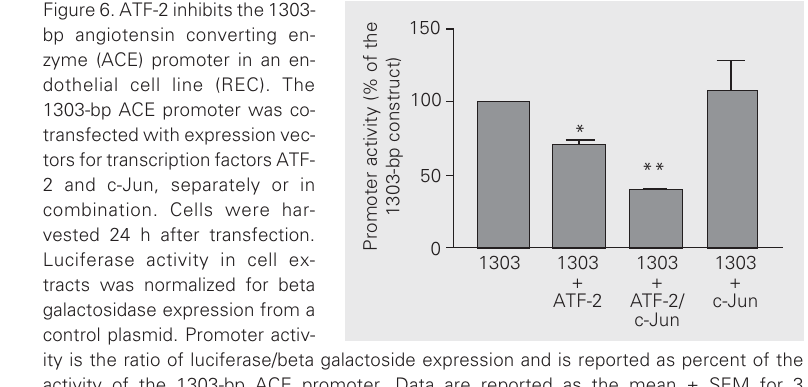
Figure 7. cAMP regulation of the 1303-bp angiotensin converting enzyme (ACE) promoter in an endothelial cell line (REC). The 1303-bp ACE promoter, positive controls for stimulation of the cAMP-responsive elements (CRETK) and AP2 (AP2LUC) pathways and a negative control (TATA) were co-transfected with expression vectors for AP2 when appropriate. After 24 h of transfection, cells were serum- starved for 16-24 h on F12 supplemented with 0.5% FBS. Transfected cells were then stimulated with 5 mM 8BrcAMP for 4 h when indicated. Luciferase (LUC) activity in cell extracts was normalized for beta galactosidase expression by a control plasmid. Promoter activity is the ratio of luciferase/ beta galactoside expression and is reported as percent induction compared to control values for each construct. Data are reported as the mean ± SEM for 4 independent experiments (N = 6). *P < 0.01 indicates statistically significant induction from unstimu- lated controls (one-way analysis of variance and post hoc Tukey